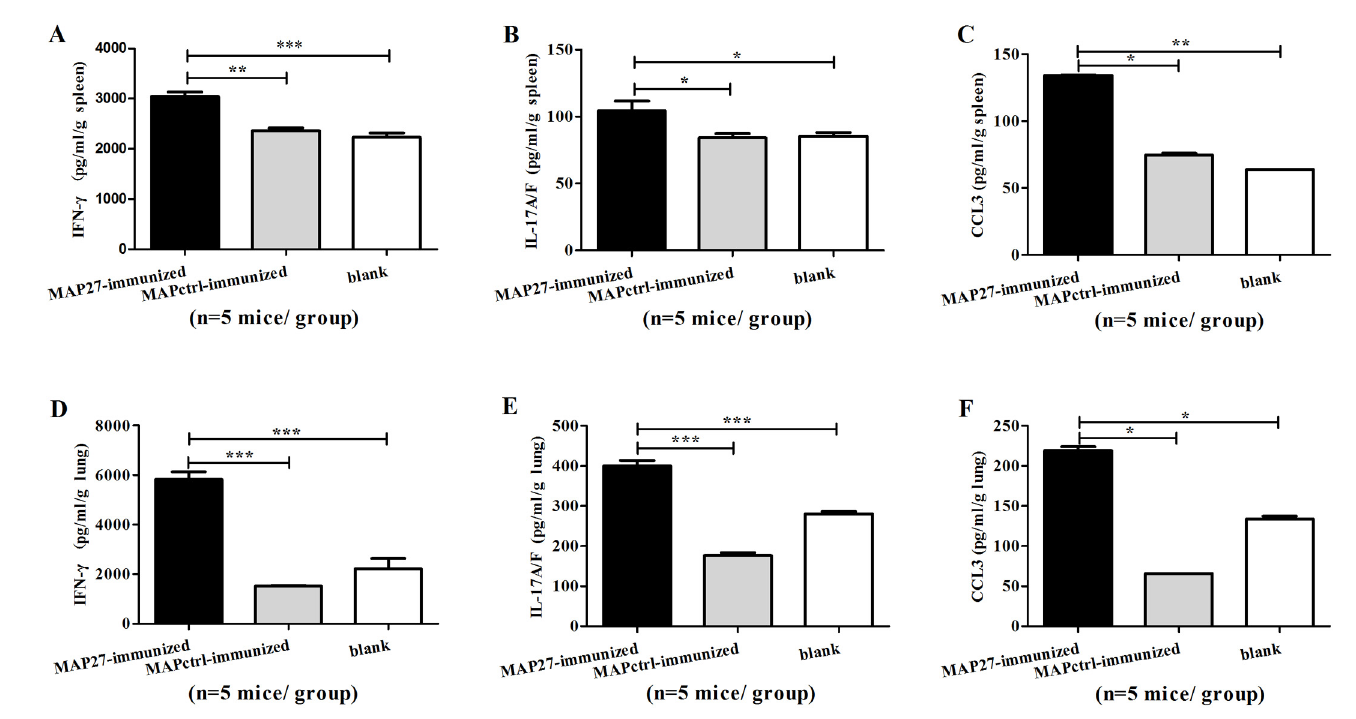
Fig 4. Immunization with MAP27 promoted IFN- γ , IL-17A/F and CCL3 production in organs post infection with S . aureus . Five days after boosting with heat-inactivated S . aureus , all of the mice (n = 5 mice per group) were infected with S . aureus (2×10 7 CFU/mouse) for three days. Spleen and lung were aseptically taken and homogenized with sterile PBS. The supernatants were pooled and analyzed by ELISA. The concentrations of IFN- γ (panel A and D), IL- 17A/F (panel B and E), and chemokine ligand 3 (CCL3, panel C and F) were measured in spleen and lung, respectively. * P < 0.05, ** P < 0.01, *** P < 0.001.